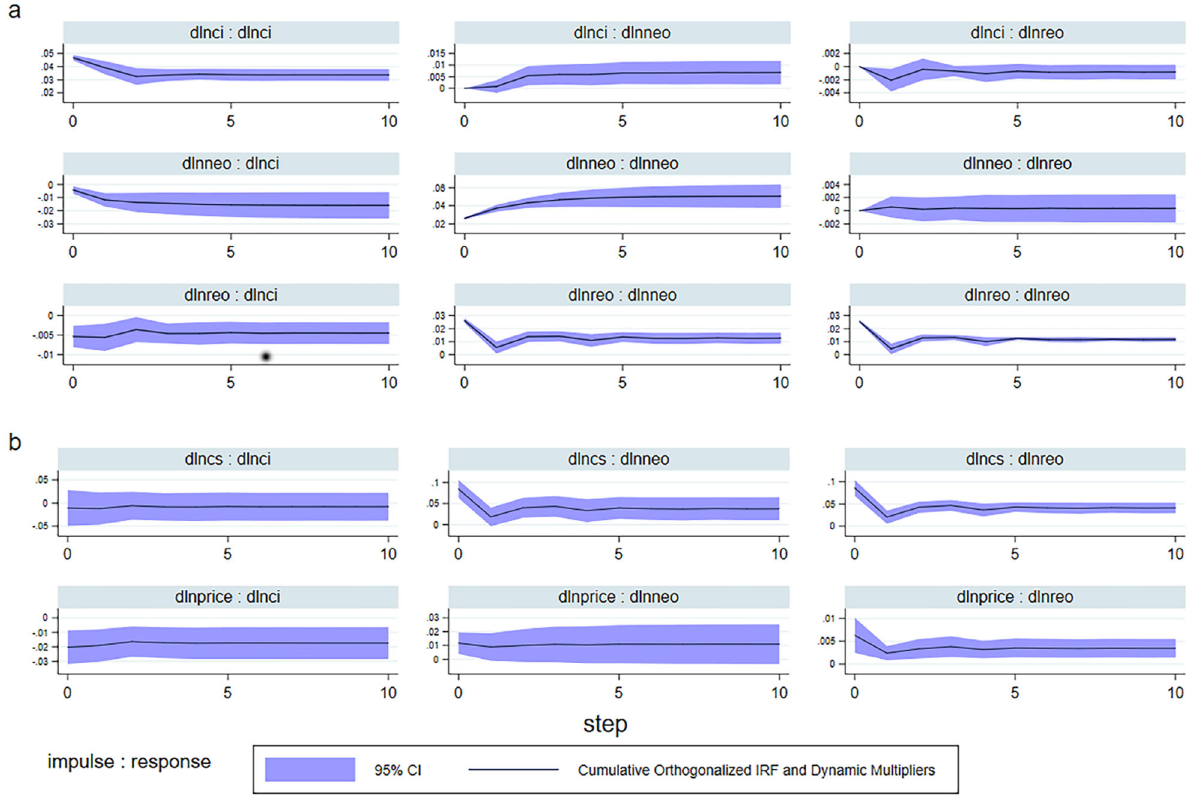
Fig. 5 Global cumulative generalised impulse responses based on orthogonalization and dynamic multipliers. a The global cumulative generalised impulse responses of neo (net economic output) growth, reo (ratio of neo to GDP) growth and ci (carbon intensity) growth based on orthogonalization. b The global dynamic multipliers of CO 2 absorbed by net primary production (cs) growth and carbon shadow price (price)